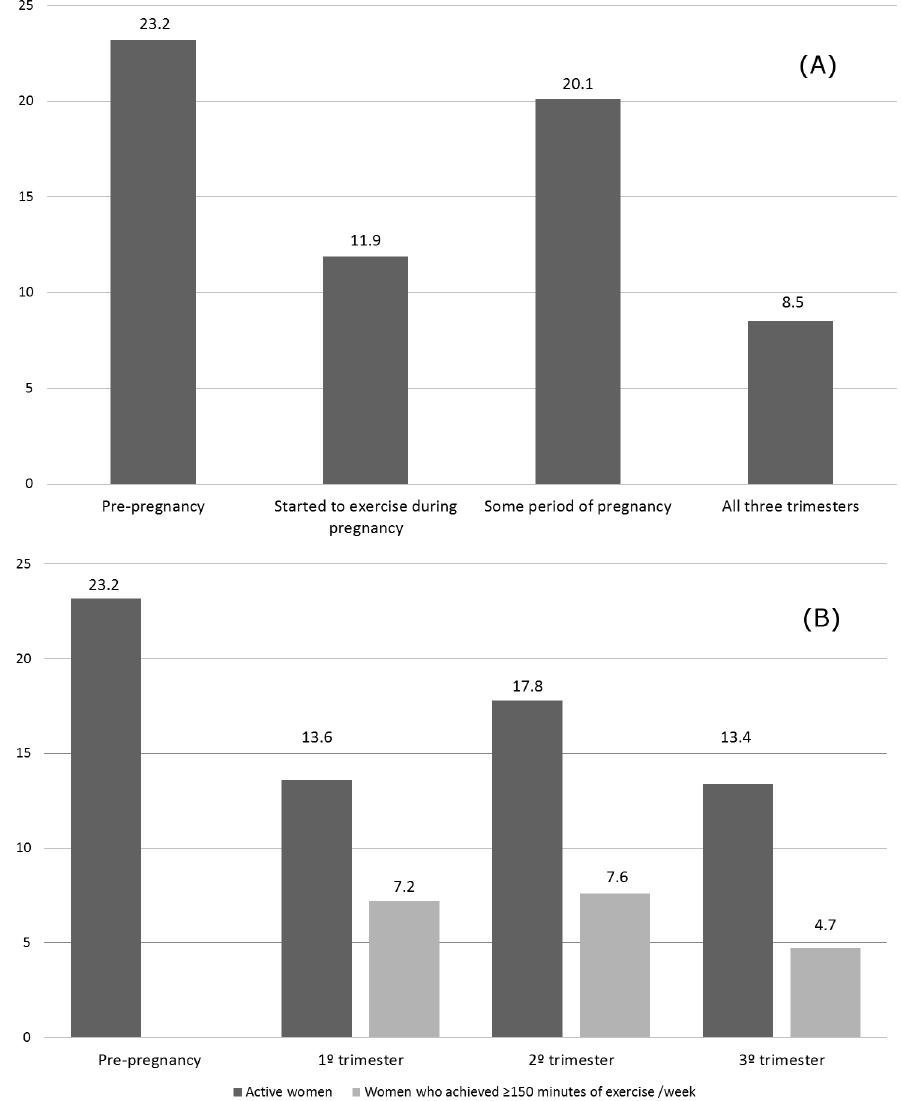
Fig 1. Prevalence of exercise practice before and during pregnancy in different gestational period and according to exercise criteria: active or ACOG criteria. (A) Frequencies of pre-gestational exercise vs. exercise some period of pregnancy (p = 0.01); pre-gestational exercise vs. all three trimesters (p < 0.0001). (B) Pre-gestational exercise vs. exercise at 1 st , 2 sd e 3 tr trimesters (p < 0.0001); exercise 1° vs. 2° and 2° vs. 3° trimesters (p < 0.0001) — McNemar Qui-square test. Frequency of exercise according to ACOG recommendations (150 minutes/week).